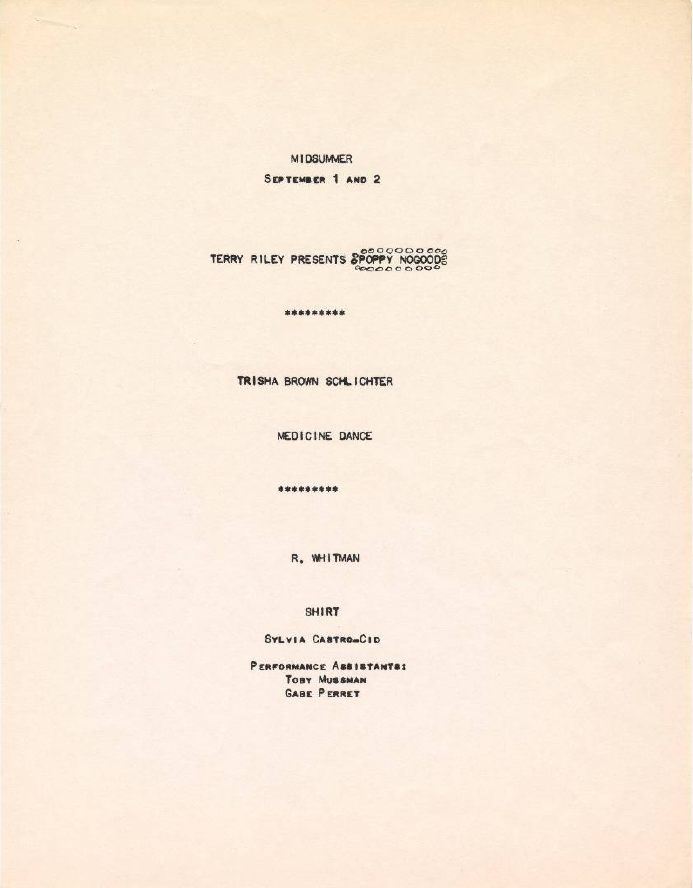
Figure 1. Page from the program for “Midsummer,” 1967. Courtesy of Trisha Brown Archives and Jerome Robbins Dance Division, The New York Public Library.